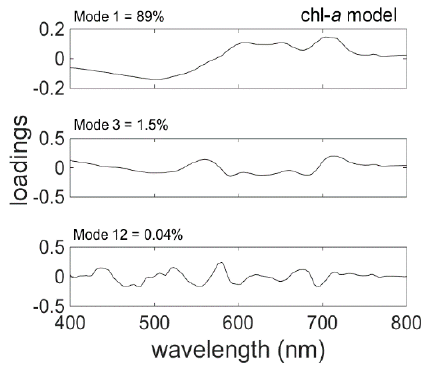
Figure 6. EOF loadings versus wavelength for the chl- a model showing percent contribution to the total variance in R rs . Modes are shown in order of being included in the model with increasing p value.